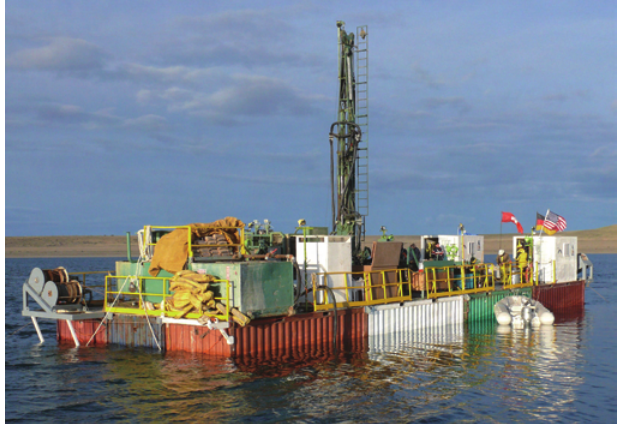
Figure 3. Platform R/V Kerry Kelts with the GLAD800 drilling system